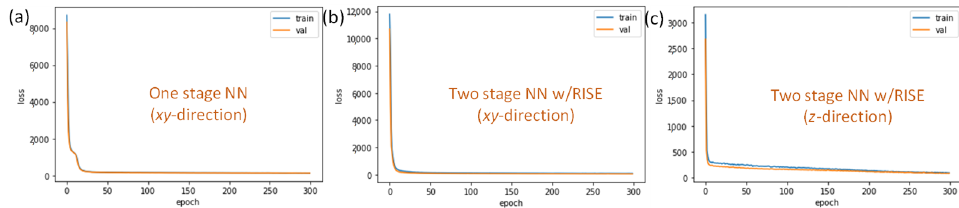
Figure 12. Loss performance during the training and validation processes using ( a ) one stage NN ( xy ), ( b , c ) TSNN with RISE ( xy and z ).